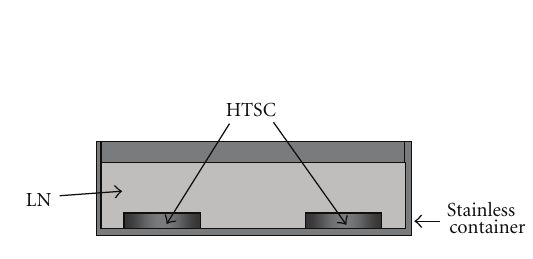
Figure 5: Cross-section of the levitated conveyer.